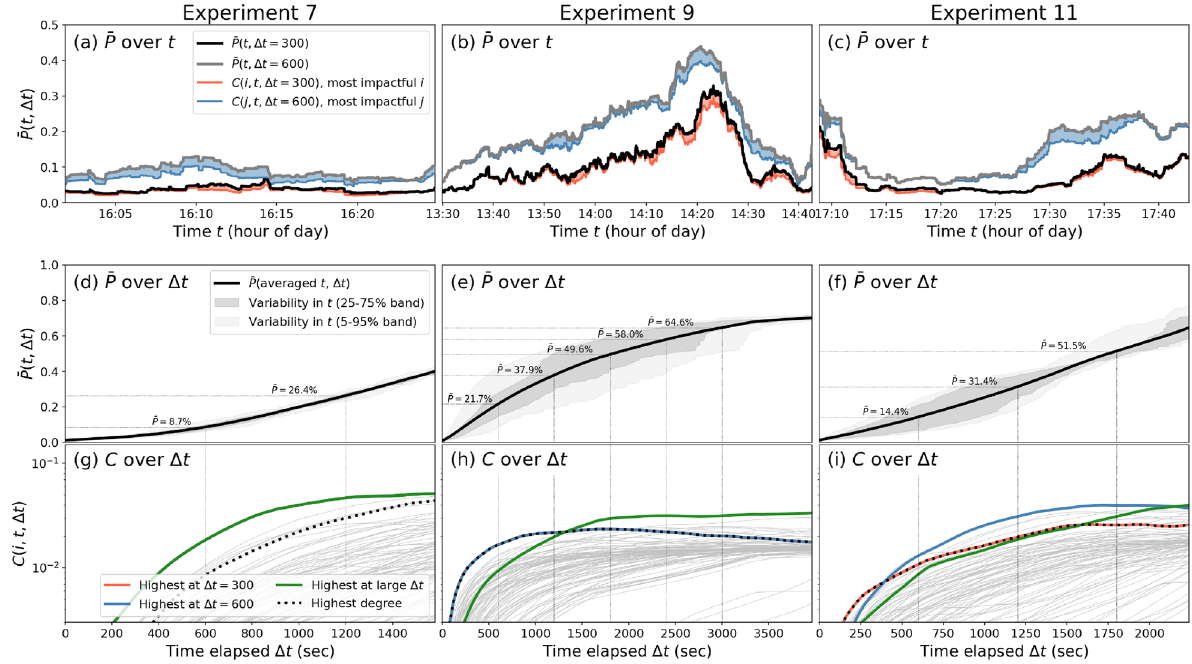
¯ P Figure 3. Evolutions of and C of experiments 7 (left column), 9 (middle column) and 11 (right column). ¯ P ( t , � t ) Panels (a–c) : Evolution of over time t at (cid:31) t = 300 s (black/red) and (cid:31) t = 600 s (gray/blue). We also ¯ P show − i ( t , � t ) (red and blue curve, respectively) and C ( i , t , � t ) (red and blue area) for the most impactful ¯ P ( t , � t ) agents i at these levels of (cid:31) t . Panels (d–f) : Evolution of over elapsed time (cid:31) t , averaging over t , for the ¯ P ( t , � t ) same experiments 7, 9 and 11. For a few values of (cid:31) t , we indicate the value of . Panels (g–i) : Evolution of C ( i , t , � t ) for each agent i (in gray). Specific agents are denoted in colors: the agents with the highest C at (cid:31) t = 300 (red) and 600 s (blue) as in panels ( a – c ), the agent with the highest C at a near-maximum (cid:31) t (i.e., 90% of the maximum time elapsed) in green, and the agent with the highest static contact degree as a black dashed line. Note that in panel ( g ), the red, blue and green lines overlap (only green shows), and in panel ( h ), the red and blue overlap (only blue